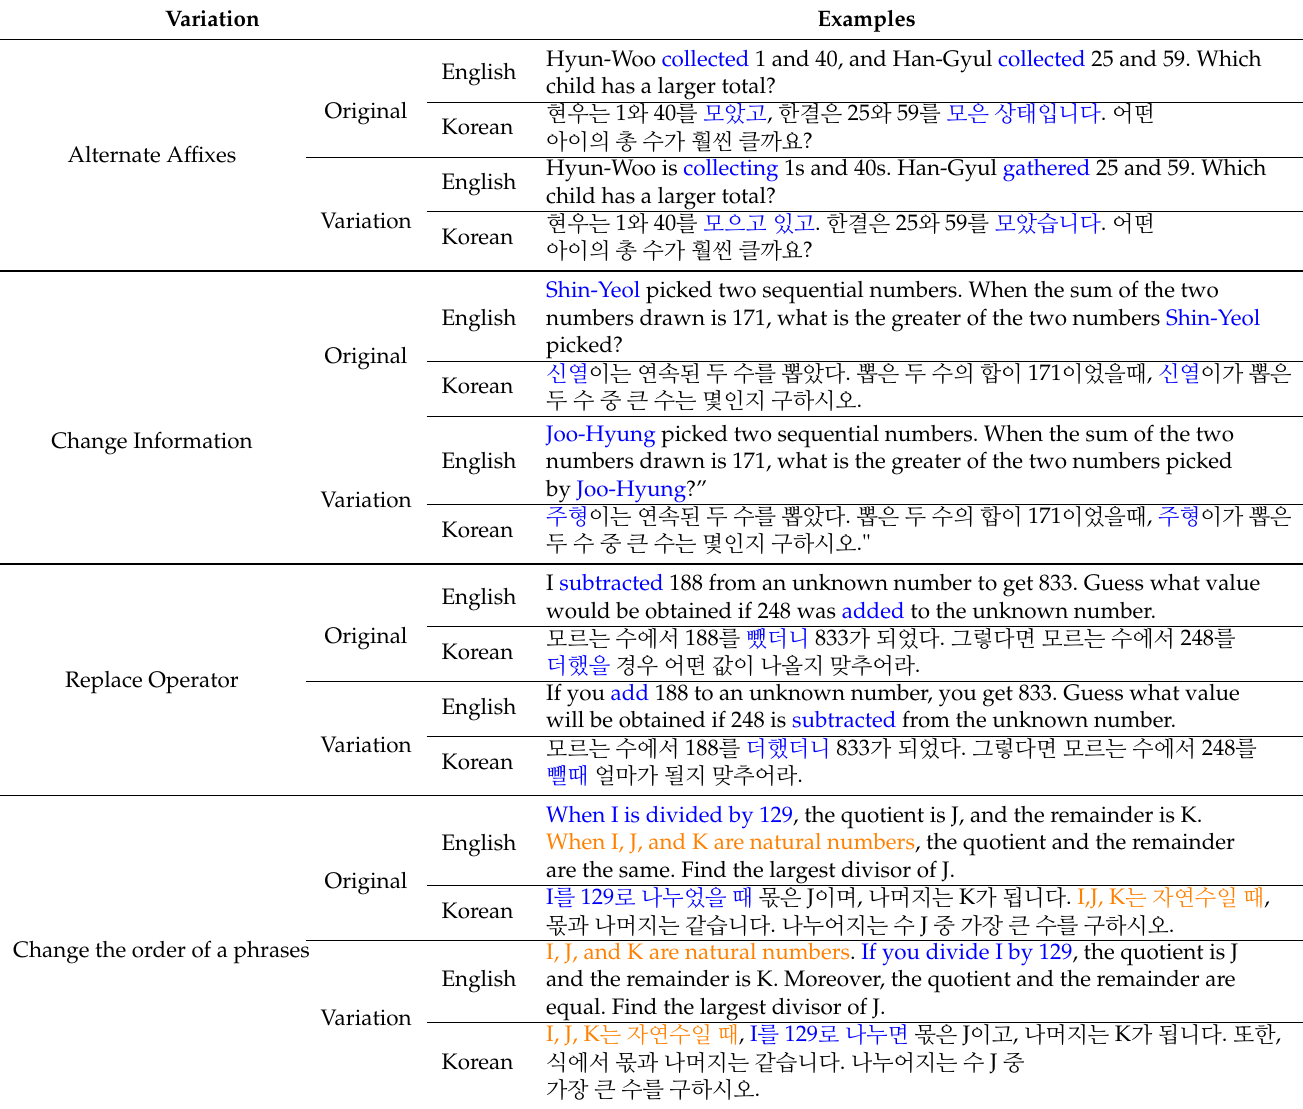
Table 5. Types and examples of variations. Colored text represents changes via